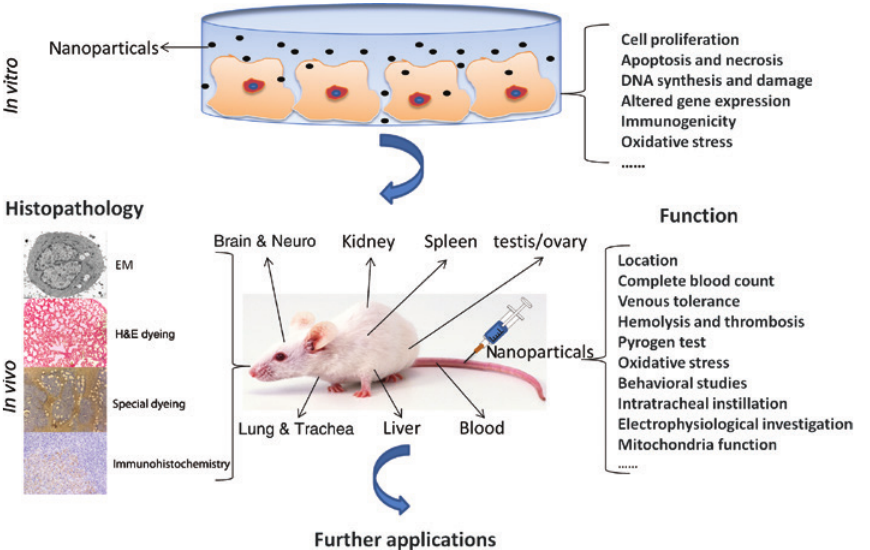
Figure 1: In vitro toxic characterization has been tested in respect to proliferation, necrosis, apoptosis, DNA damage, and oxidative stress. Mice and rats would be more appropriate models due to their explicit genome for toxicity tests of organs including hepatic and renal, gastro- intestinal, pulmonary, hematological, cardiovascular, nervous, reproductive, and immune systems in terms of histopathological changes and functions.